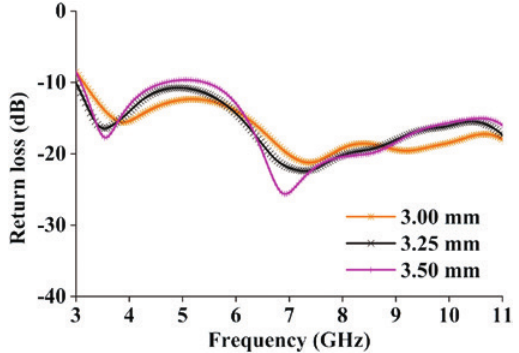
Figure 5: Effects of return loss with different values of F